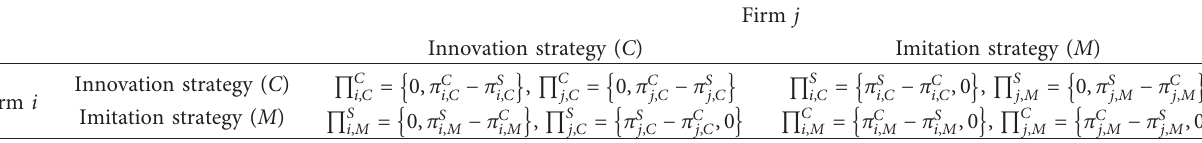
Table 2: The payoff matrix based on the prospect